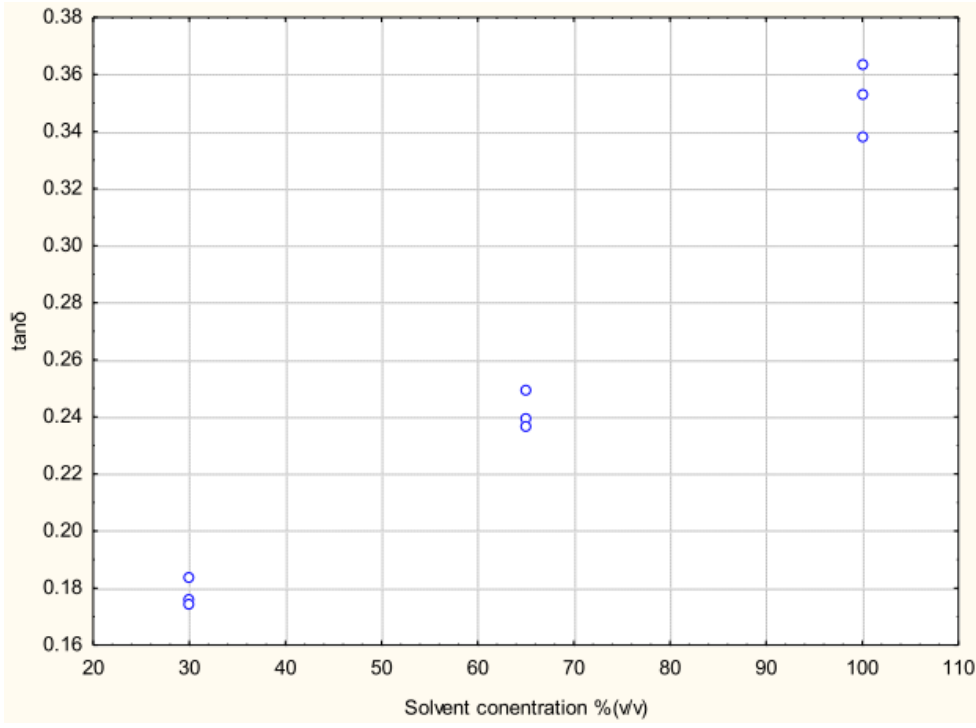
Figure 9. Effect of solvent concentration on dissipation factor (tan δ ) (Source: Adapted from [9]).